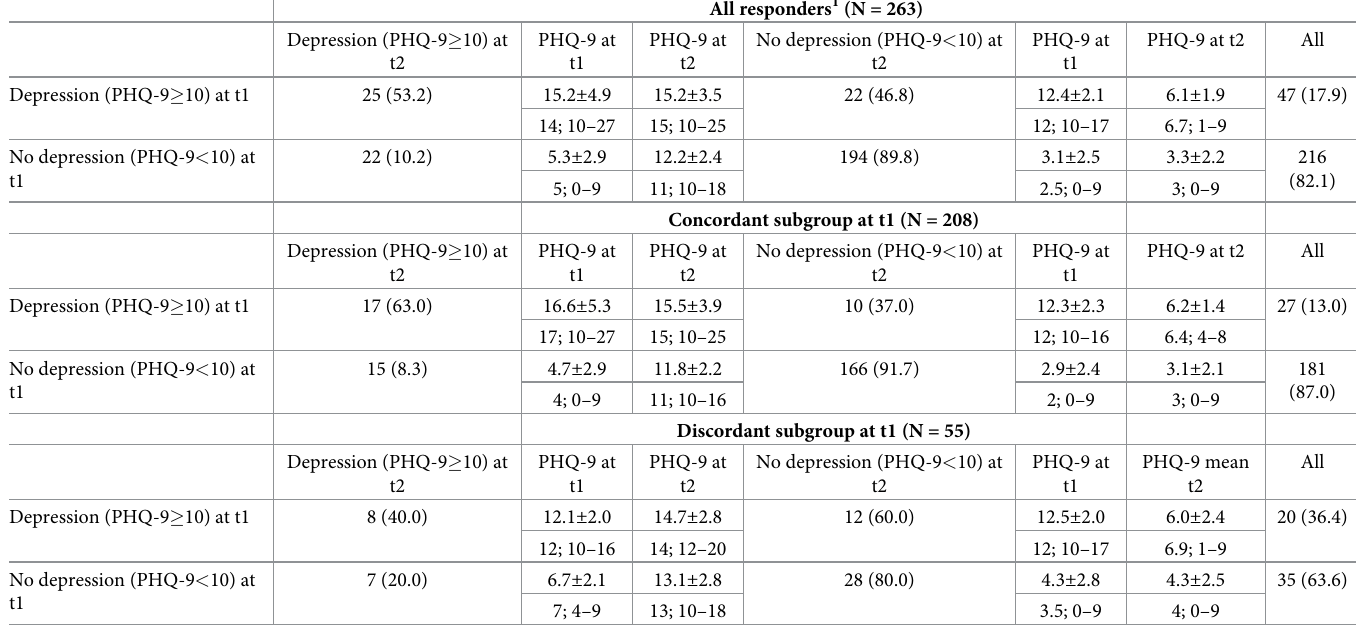
Table 2. Replicability of the PHQ-9 results at t1 and t2 alone compared to the stability of the PHQ-9 results in the PHQ-9 and GP rating concordant vs. discordant subgroup at t1.